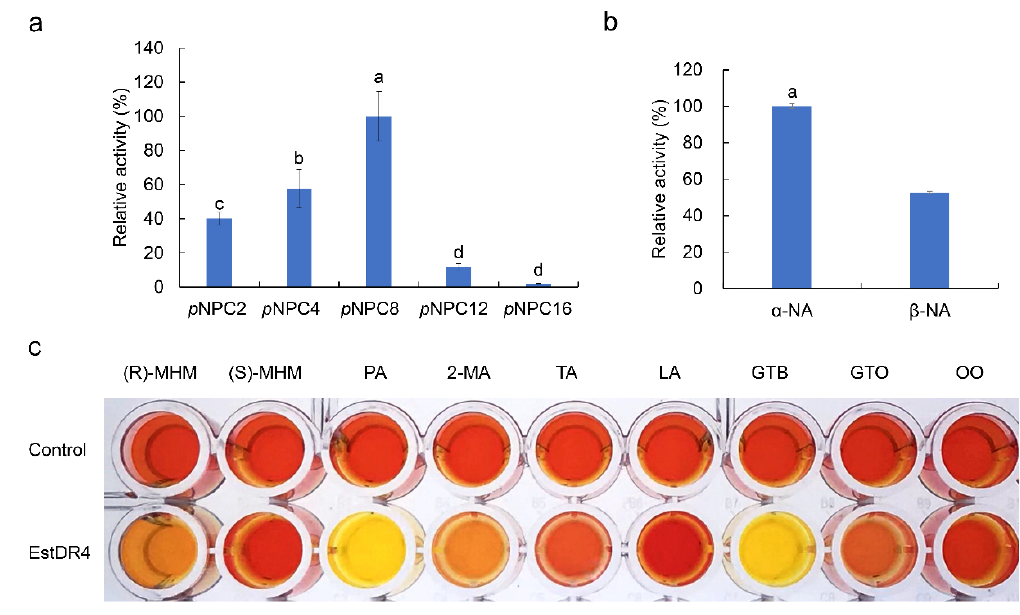
Figure 3. Substrate specificity of EstDR4. ( a ) Substrate specificity of EstDR4 toward p NPC2, p NPC4, p NPC8, p NPC12, and pNPC16. The maximum activity measured towards p NPC8 was taken as 100%. ( b ) Substrate specificity of EstDR4 toward α -NA and β -NA. The different letters between each condition in ( a , b ) indicate significant differences ( p < 0.05). ( c ) Substrate specificity of EstDR4 toward (R)-MHM, (S)-MHM, PA, 2-MA, TA, LA, GTB, GTO, OO.